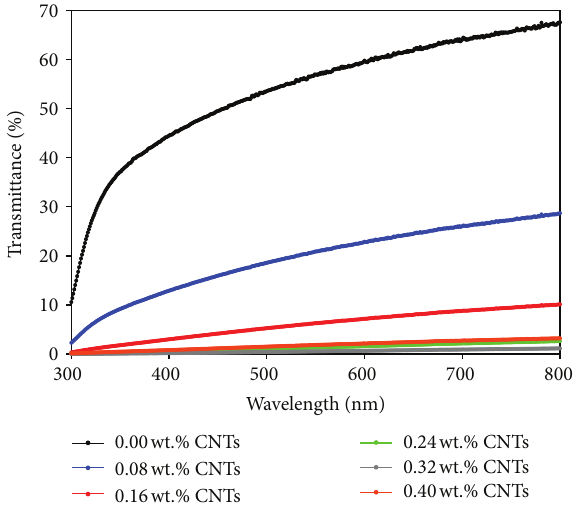
Figure 5: Optical transmittance of coating films prepared; the line is a guideline for the